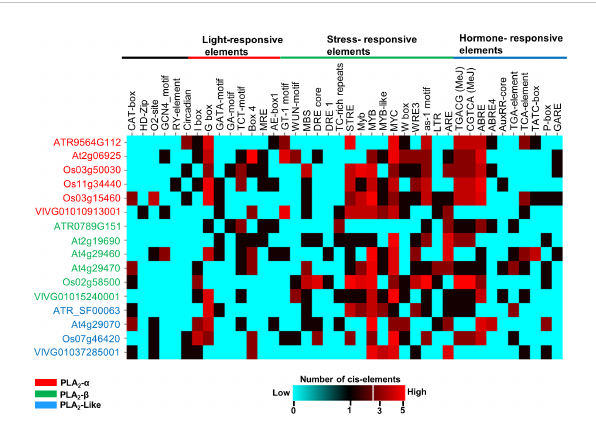
FIGURE 4 In-silico prediction of cis -acting elements in the promoter region (5 ’ upstream region about 2kbp) using PlantCARE database. The number of elements in the promoter regions was depicted by a heatmap using the CIMminer web tool. The color code represents the number of cis-elements in the promoter regions; Cyan- 0 (absent), Red- 5 copies of the